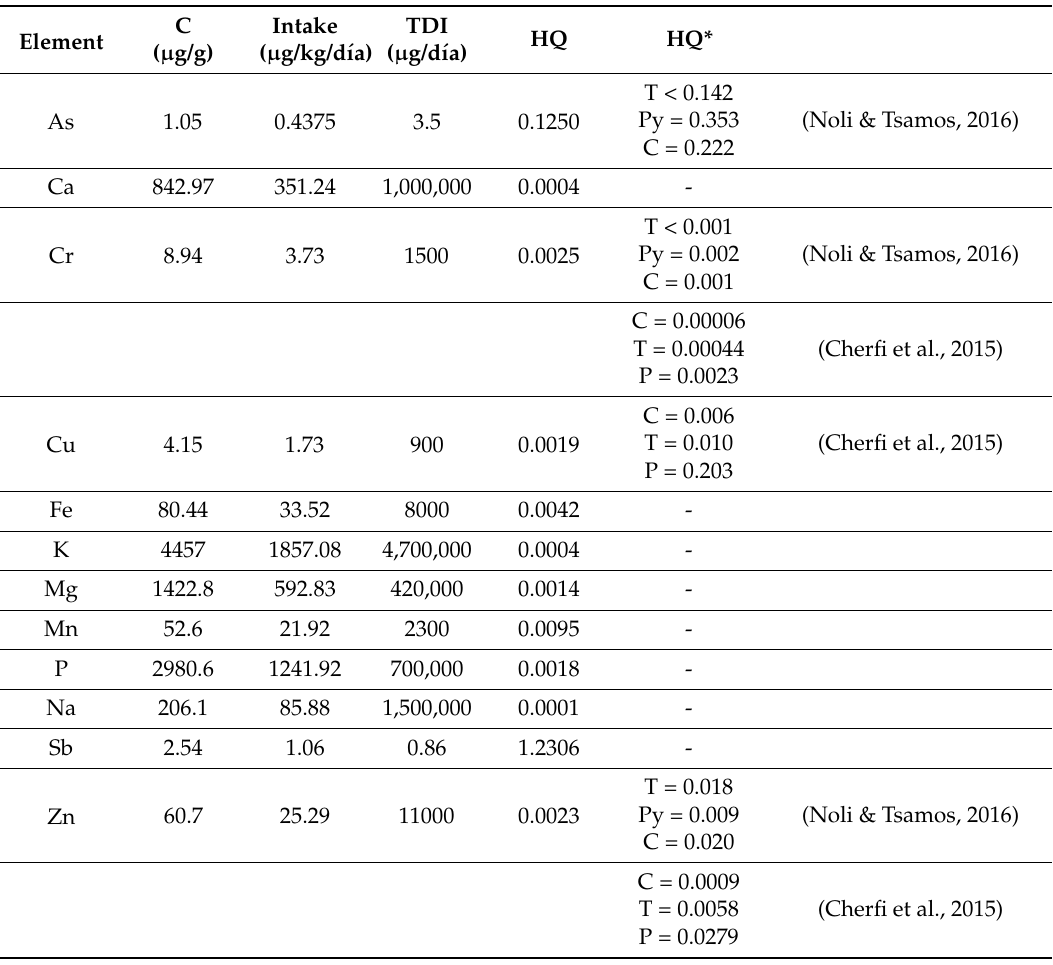
Table 6. Hazard risk quotients for walnut (HQ) and those reported in the literature